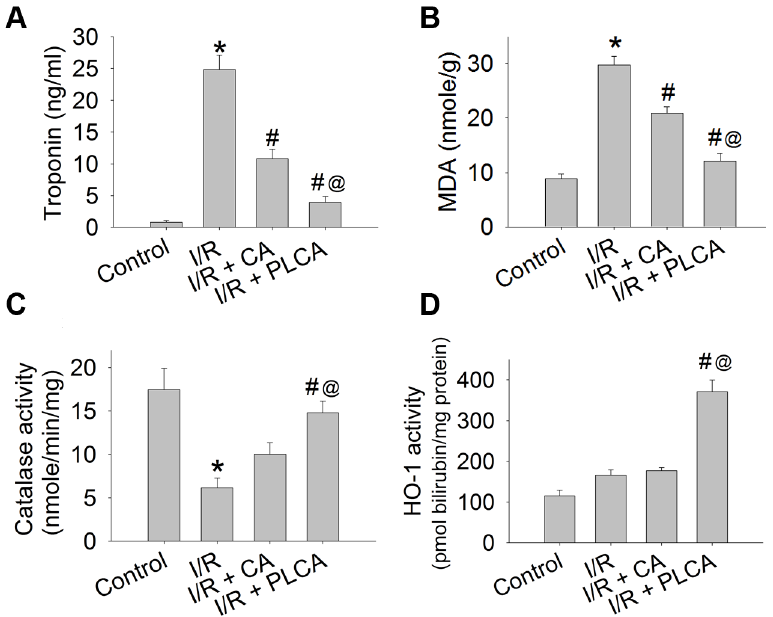
Fig 2. Effect of CA and PLCA on myocardial I/R stress induced oxidative injury and changes of protein activity. Cardiac oxidative injury and protein activity were shown in rats subjected to 1 h coronary artery occlusion and followed by 2 h reperfusion. (A) Troponin concentration, (B) lipid peroxydation, (C) catalase activity, and (D) HO-1 activity were measured. (n = 6) * P < 0.05 vs. control, # < 0.05 vs. IR, @ < 0.05 vs.